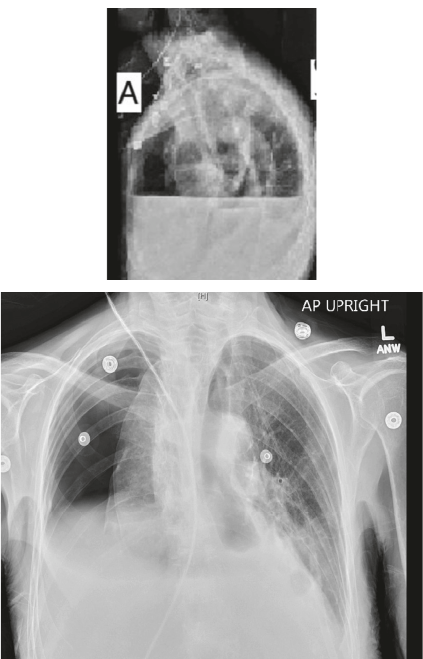
Figure 1: CXR showing a large right-sided hydropneumothorax, and the esophagus was air-filled down to the distal